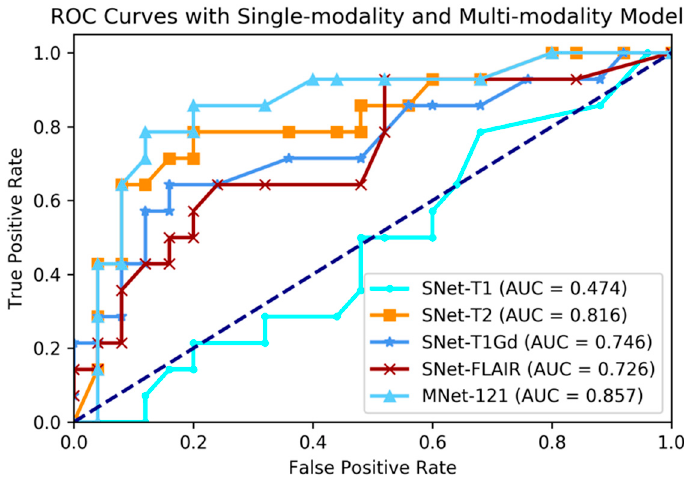
Figure 4. Comparing ROC curve between single ‐ modality and multi ‐ modality models.